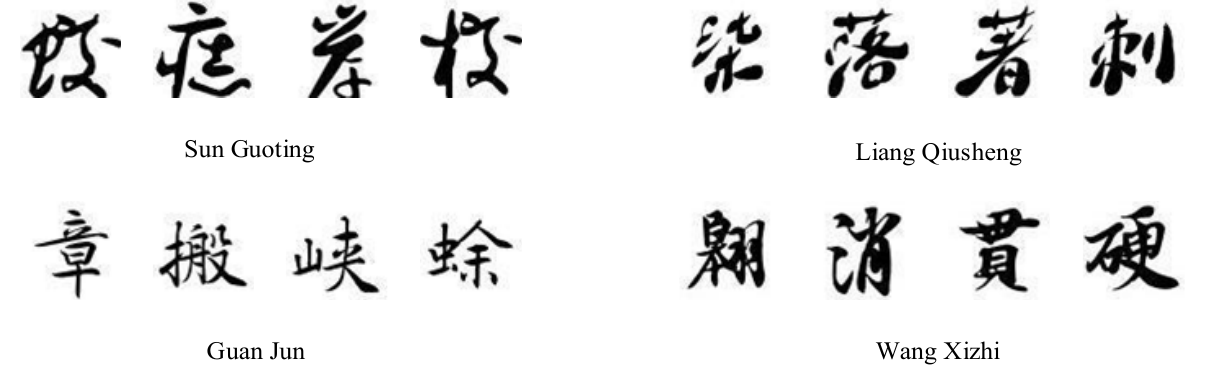
Figure 3. Examples of four different calligraphic works in the dataset.